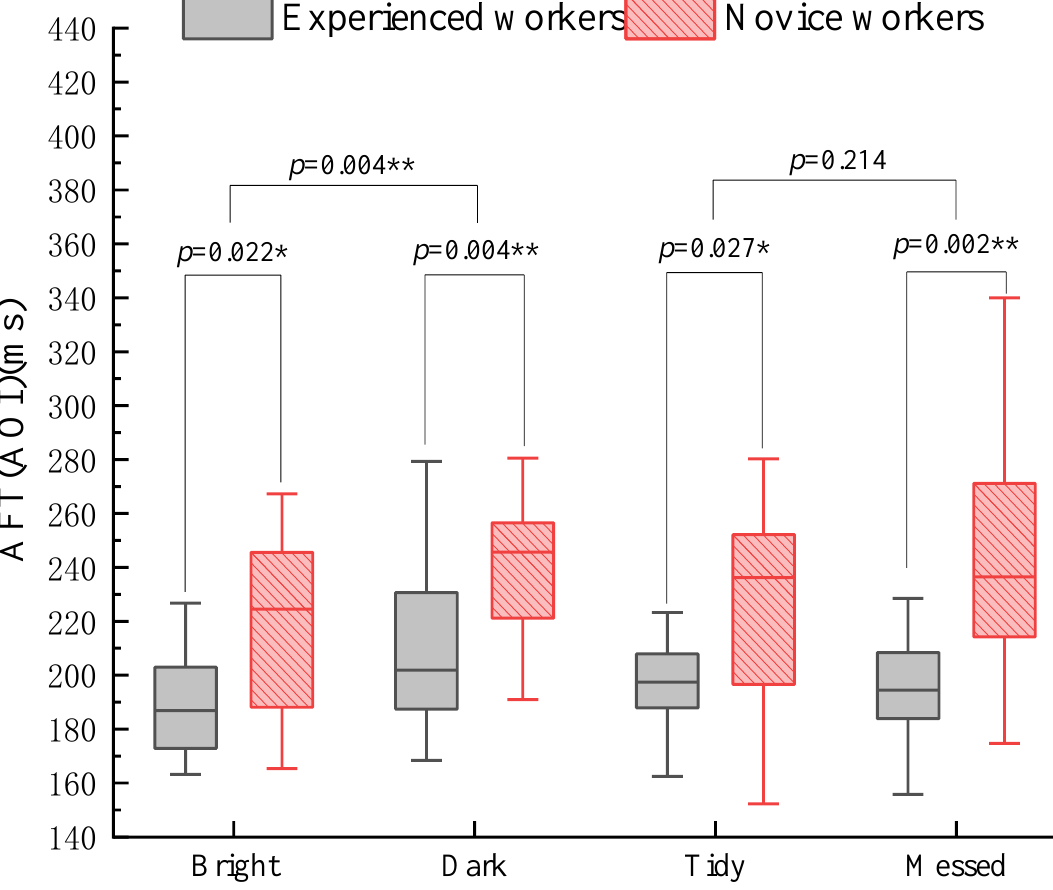
Figure 7. AFT(AOI) for experts and novices in construction sites with different environmental conditions. (* and ** indicate significant differences at the 0.05 and 0.01 levels, respectively.) Figure 8 shows the statistics of each index datum after normalization. As seen from the figure, the differences in the CRR, RFT(AOI), and AFT(AOI) between experts or novices are small, and the TFT fluctuates more, which indicates that the search efficiency varies more among subjects with the same experience. Observing the gaze points and gaze hotspots of different subjects revealed that the subjects with higher total gaze time examined all objects in the construction site more comprehensively. However, the increase in total gaze time did not have a positive effect on the correct identification of hazards, as shown in Figure 8, and it decreased search efficiency. When the subjects focused mainly on the target objects that attracted more attention or interest, the search efficiency could be improved, hazards could be found in a more timely and effective manner, and safety accidents could be avoided. Therefore, strengthening workers’ attention to areas with a high number